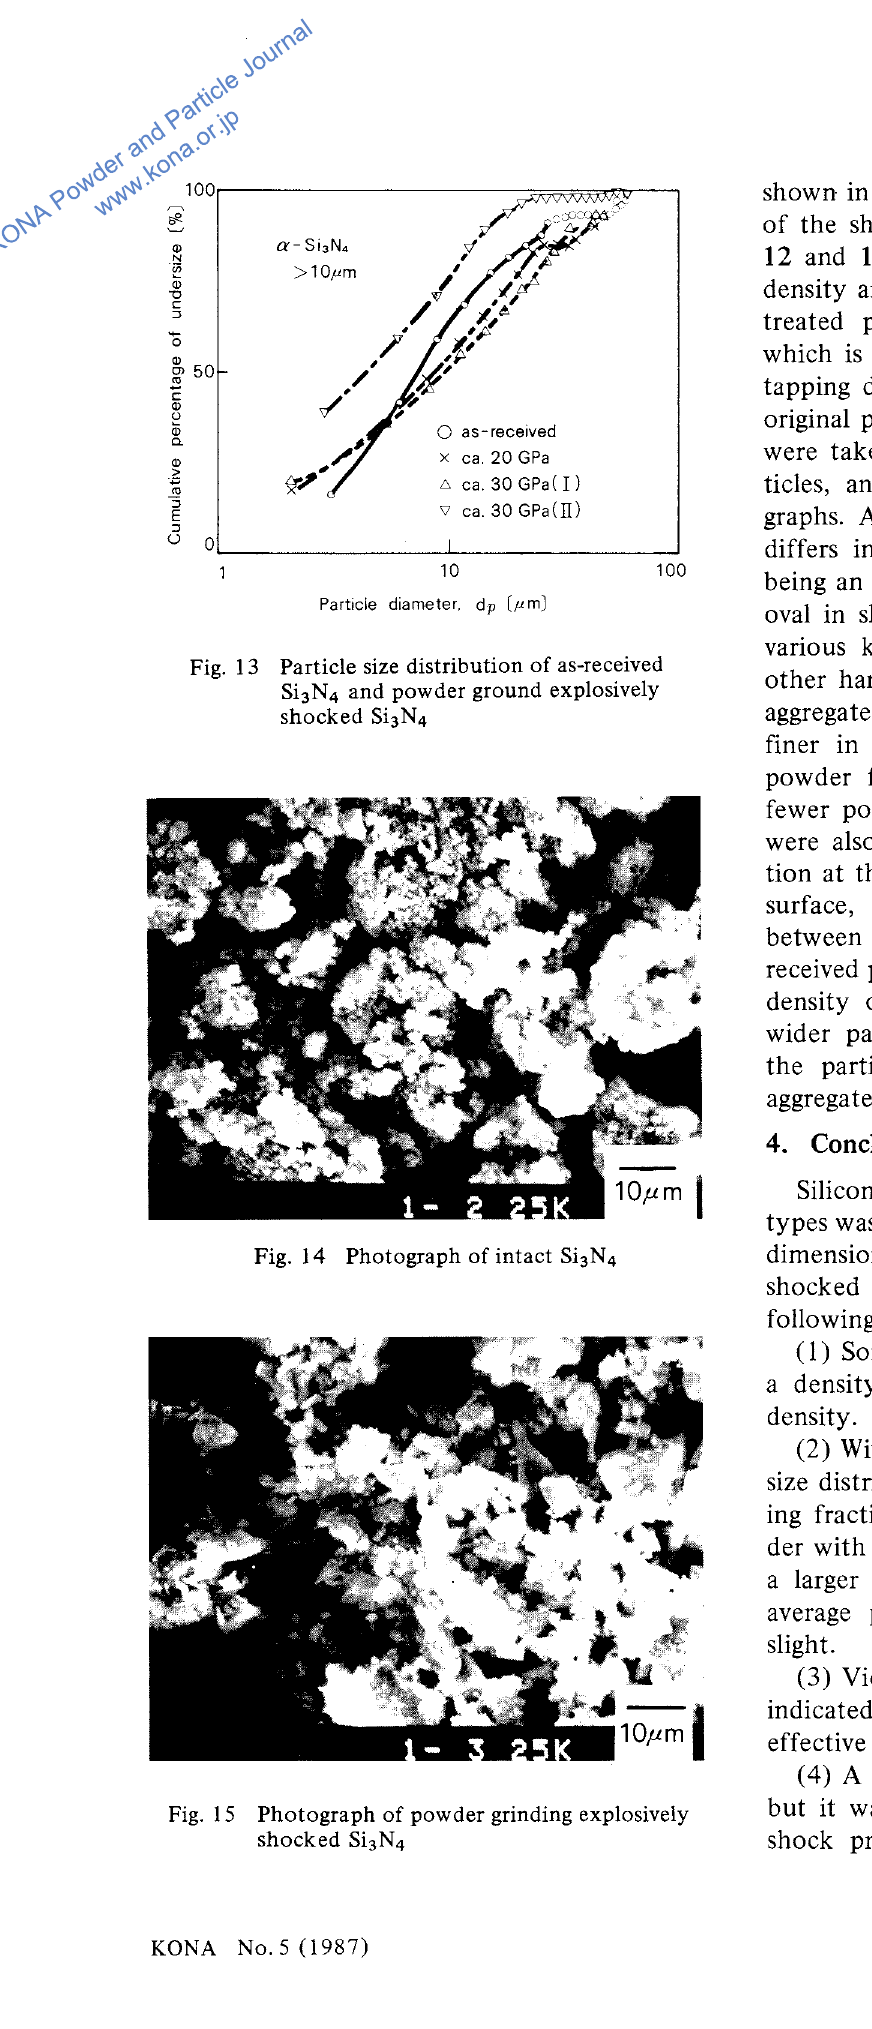
Fig. 15 Photograph of powder grinding